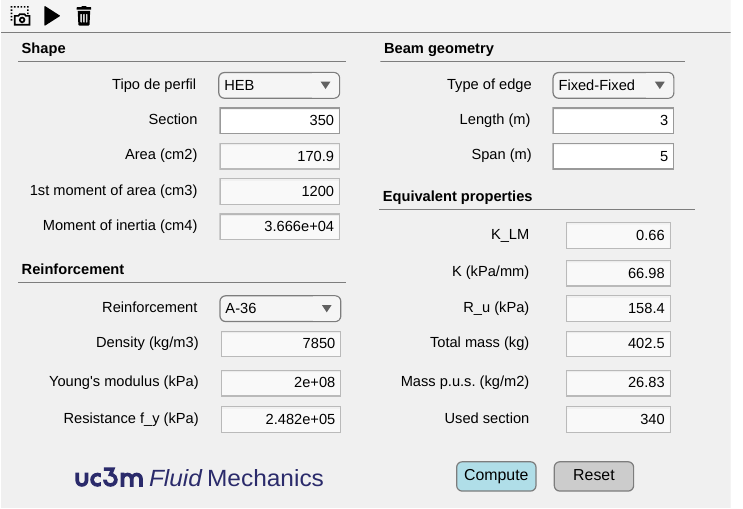
Figure 11. Metal beam calculation assistant showing results for a HEB 340 pillar with a length of 3 m and a spacing between pillars of 5 m. Note that, even though a HEB 350 is requested, which is not included in the norm, the assistant corrects down to the nearest normalized value, HEB 340.